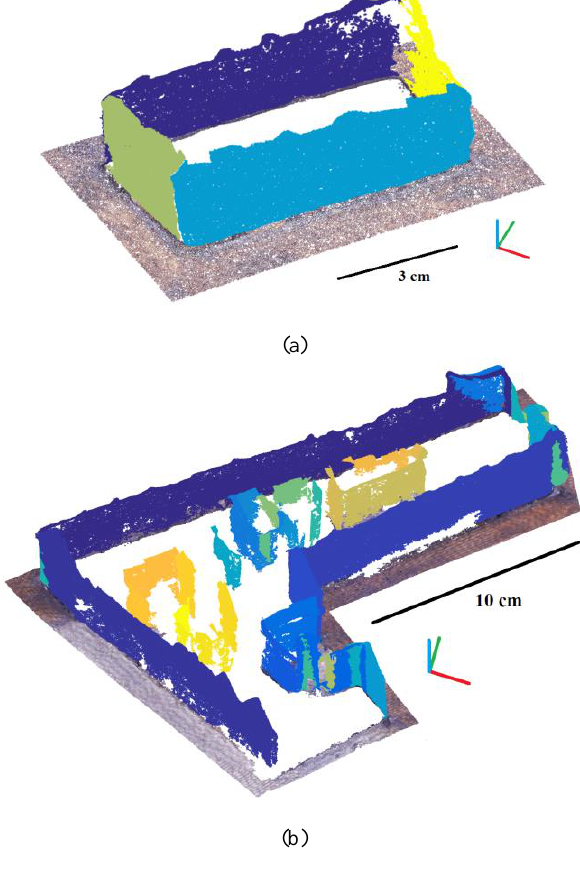
Figure 5. Extraction of ground and facades: (a) block 5; (b) block 6